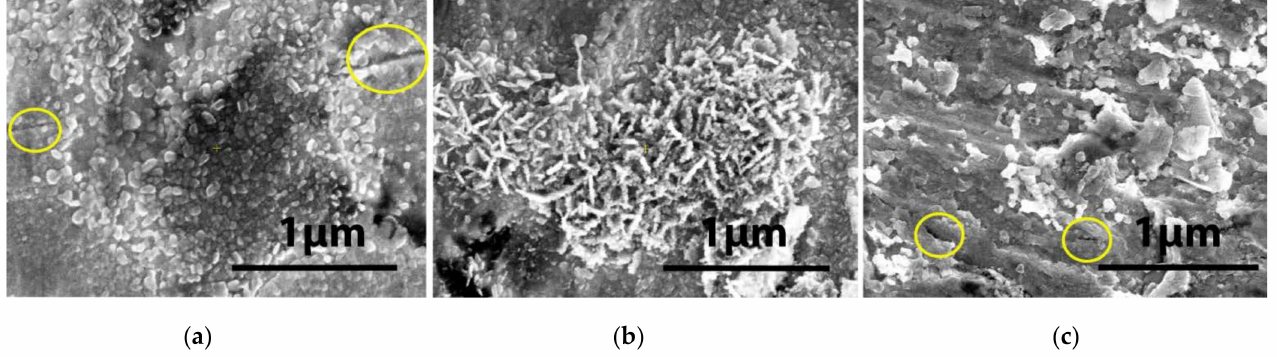
Figure 6. High-magnification SEM images of W surface after the third session of 10 min irradiation at 6 MeV: ( a ) W-Ti ( × 50,000); ( b ) W-Cu ( × 50,000); and ( c ) W-V ( × 50,000). Some observed cracks are shown with circles.